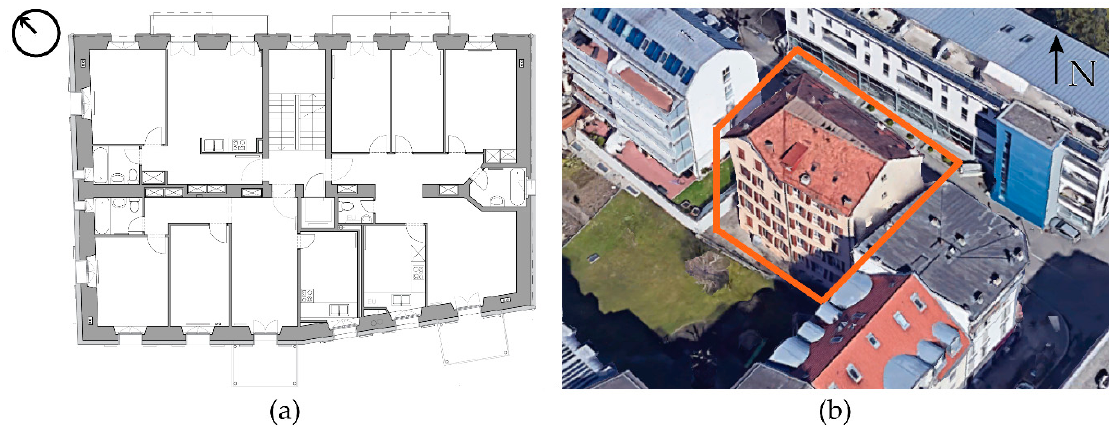
Figure 6. ( a ) Plan and orientation of the Swiss case study building; and ( b ) overview of the building and its surroundings.